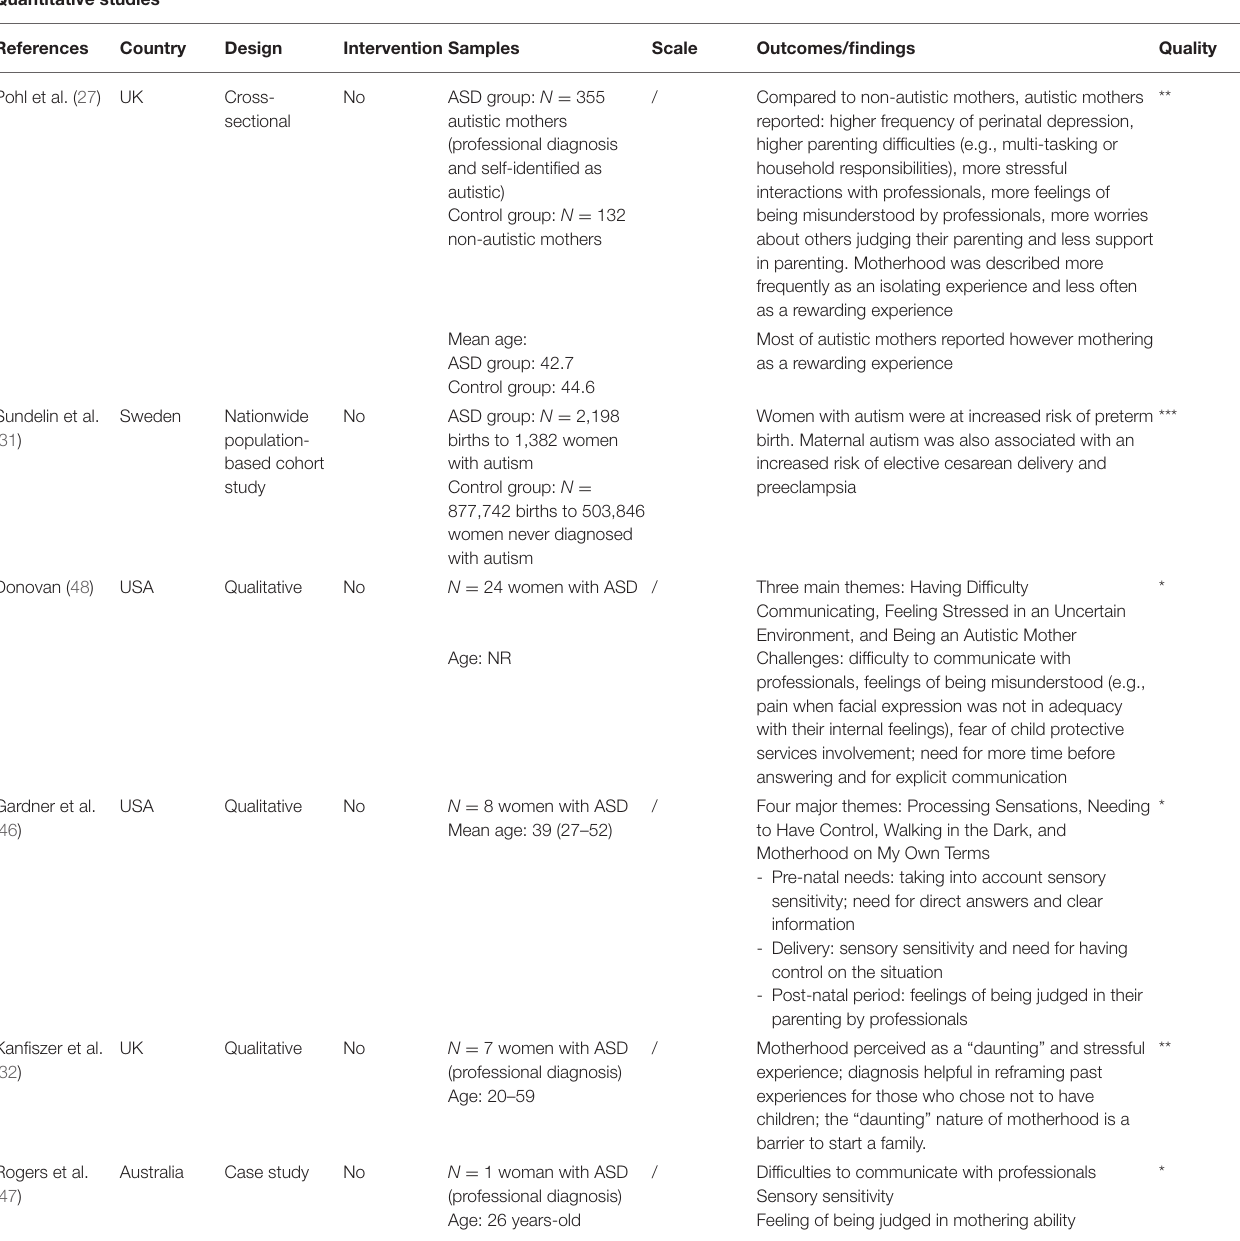
TABLE 4 | Included studies reporting on reproductive health/parenting in women with autism. Quantitative